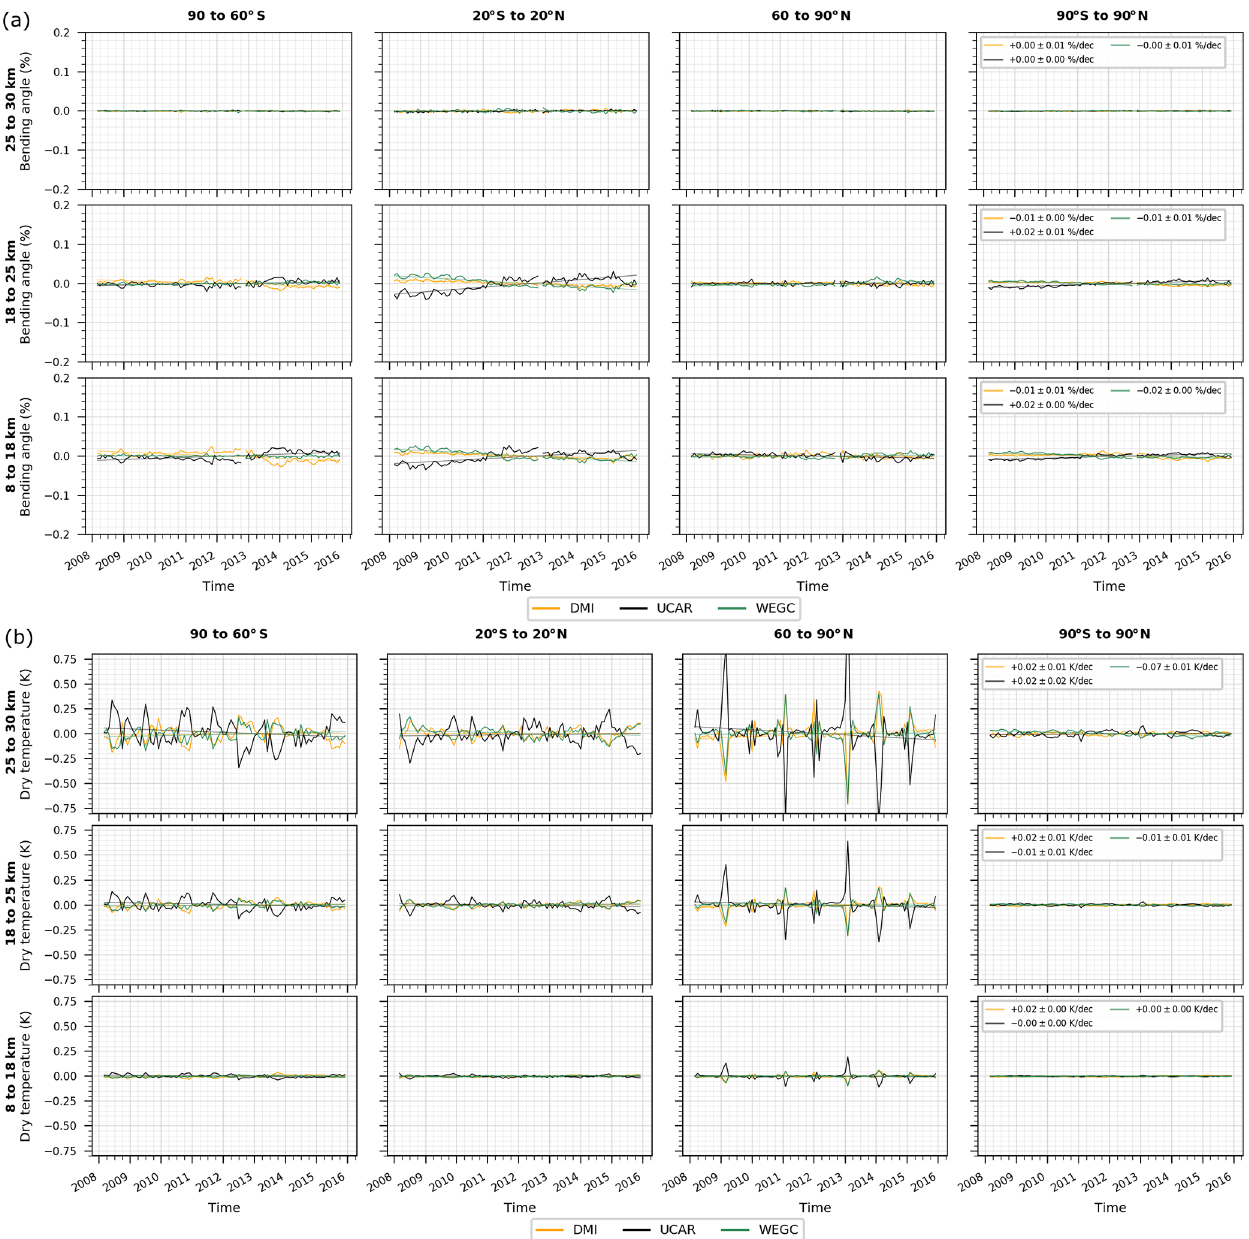
Figure 7. Metop bending angle (a) and dry temperature (b) de-seasonalized anomaly difference time series based on 10 ◦ zonal medians of each center to the all-center mean for latitude bands 90 to 60 ◦ S, 20 ◦ S to 20 ◦ N, 60 to 90 ◦ N, and globally 90 ◦ S to 90 ◦ N (left to right) for altitude layers 8–18, 18–25, and 25–30km (bottom to top). Time series from DMI (orange), UCAR (black), and WEGC (green) are